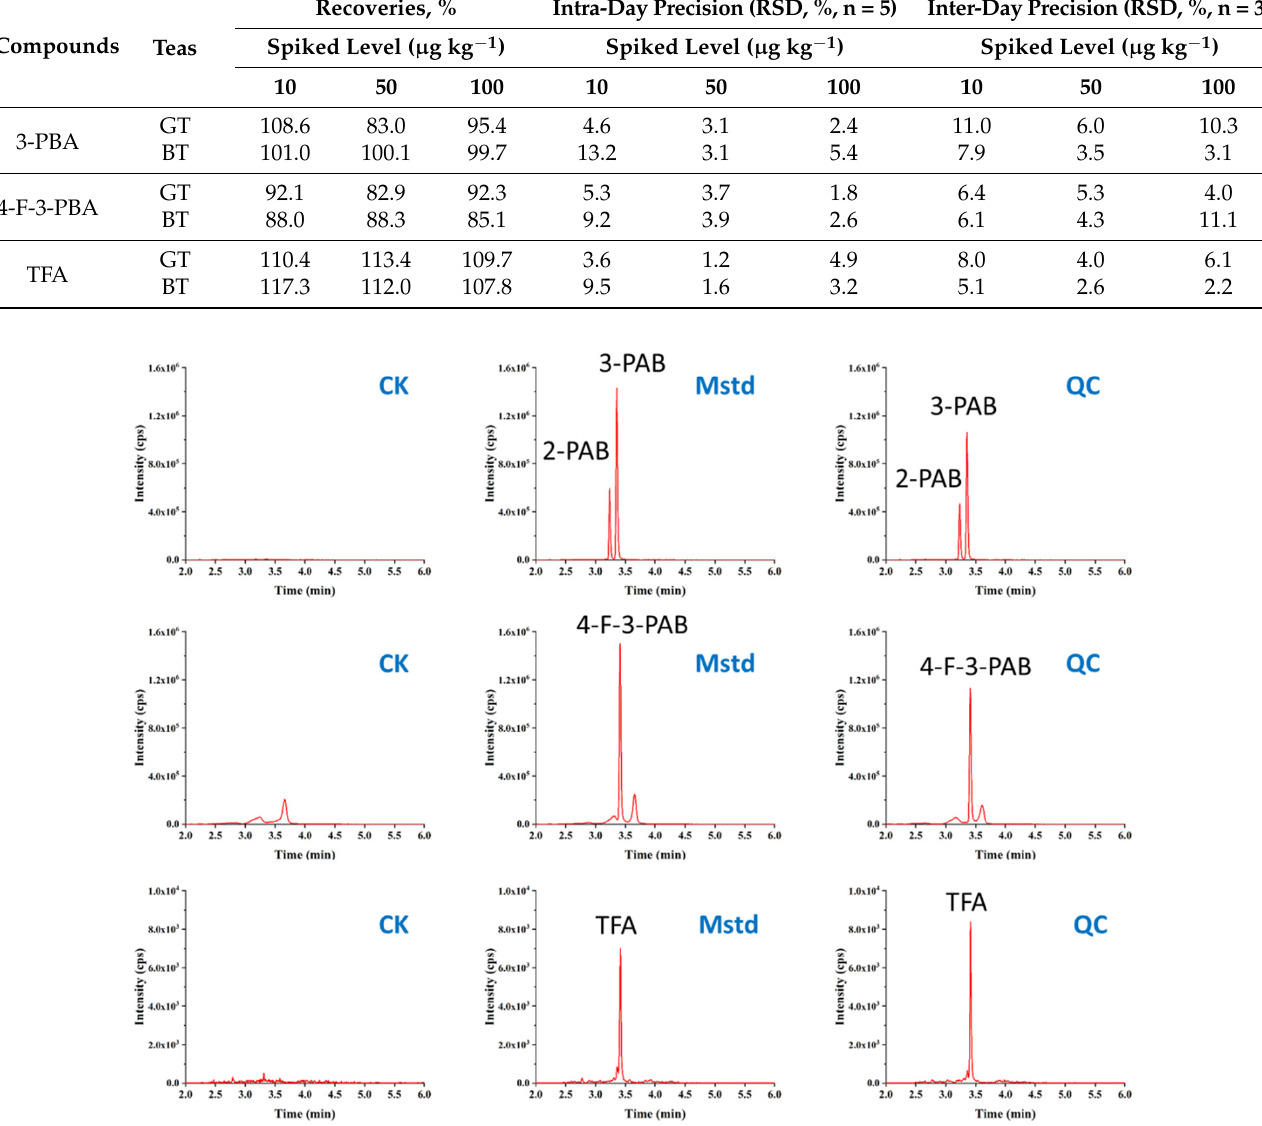
Figure 5. UHPLC-MS/MS chromatograms of 3-PBA, 4-F-3-PBA, TFA and internal standard 2-PBA in a blank green tea sample (CK), matched matrix standard calibration at 10 µ g L − 1 (Mstd), and spiked sample at 50 µ g L − 1 (QC).